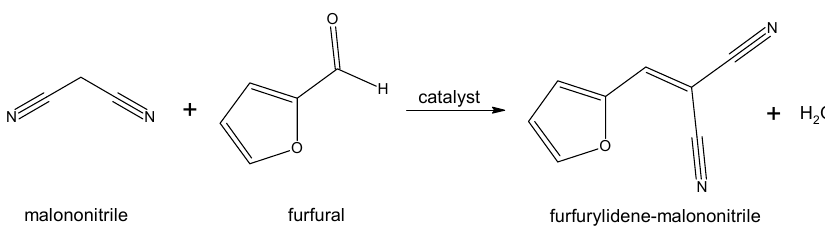
Scheme 2. The reaction between malononitrile and furfural.